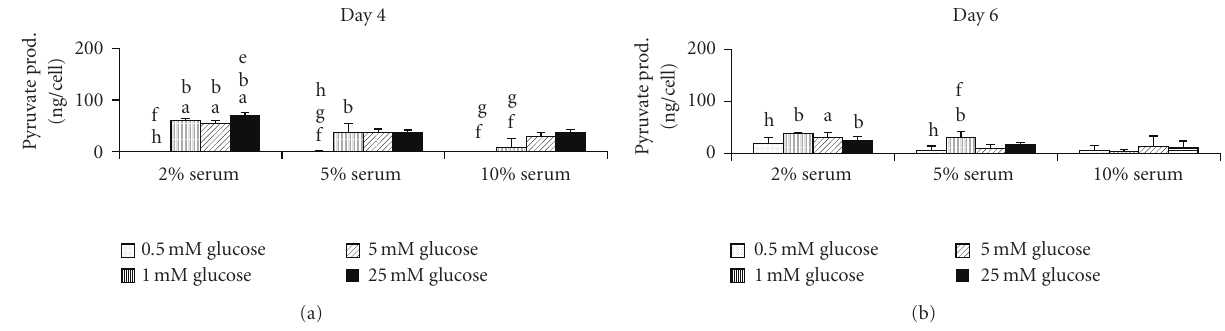
Figure 5: Extracellular pyruvate production after the final two days of two-dimensional culture ( n = 12 per group). The production data does notshowa clear trend. (a: significantlydi ff erent fromcorresponding value in the 5% group; b: significantlydi ff erent from corresponding value in the 10% group; e: significantly di ff erent from all other values within same serum group; f: significantly di ff erent from 5.0mM value within same serum group; g: significantly di ff erent from 25.0mM value within same serum group; h: significantly di ff erent from the 1.0 mM value within the same serum group; P = .